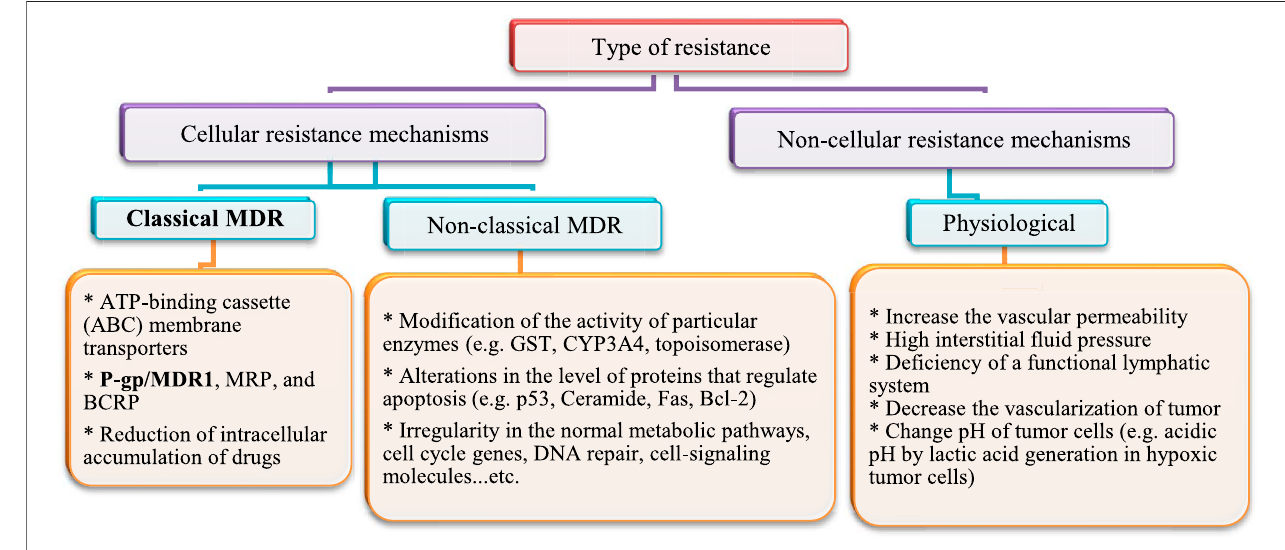
FIGURE 4 | Mechanisms of multidrug resistance (MDR) in cancer